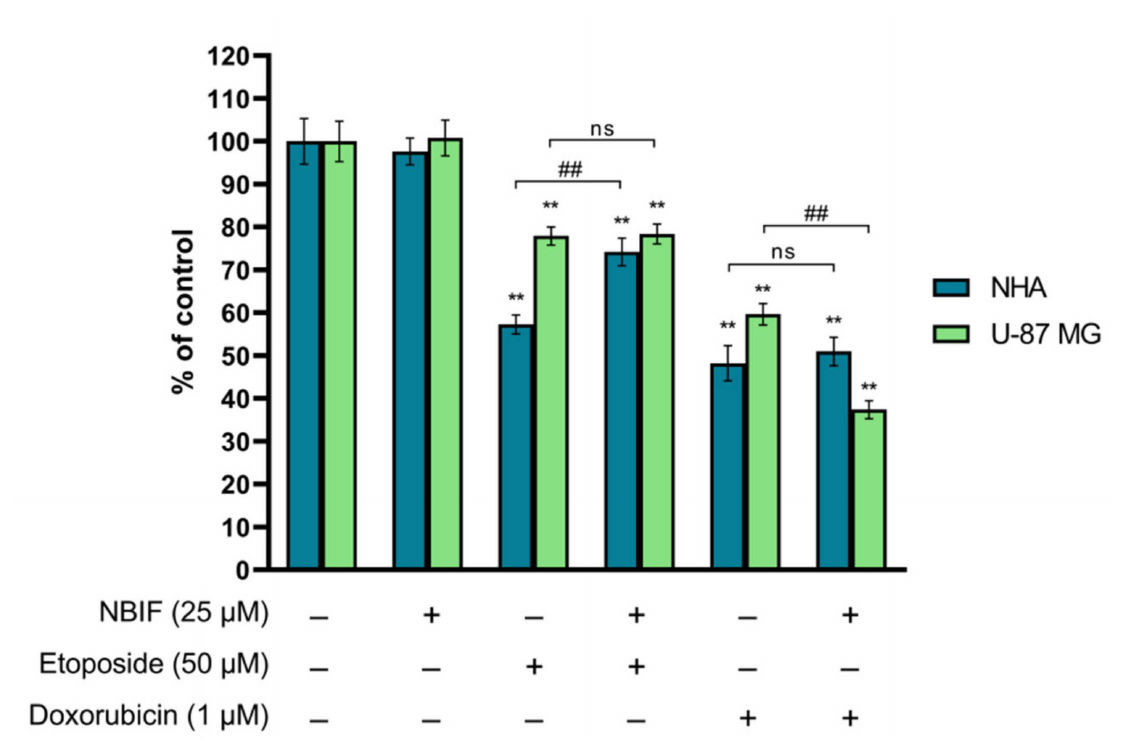
Figure 1. The effect of NBIF alone and in combination with etoposide and doxorubicin on the growth of NHA and U-87 MG cells. Cell cultures were treated with NBIF (25 µ M), etoposide (50 µ M), doxorubicin (1 µ M) and in mixes: etoposide + NBIF (50 µ M + 25 µ M) and doxorubicin + NBIF (1 µ M + 25 µ M) for 48 h. The results are presented as percent of corresponding control. ** p < 0.001 vs. control; ## p < 0.001 for comparisons between groups; ns—not